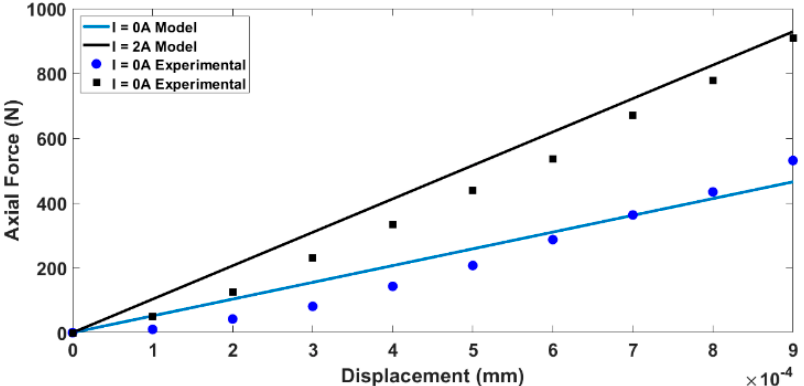
Figure 9. Comparison of the experimental and theoretical results.